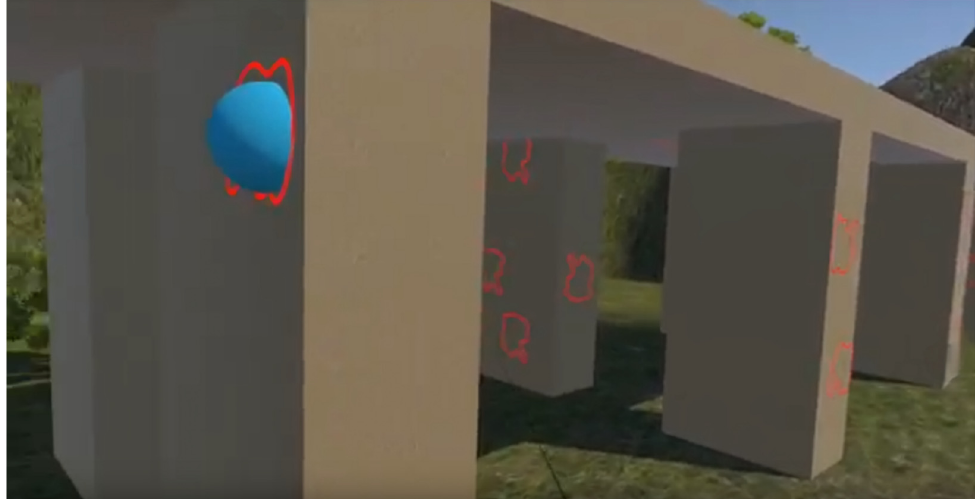
Figure 2. Simulated bridge environment as displayed to a participant during the experiment. The blue hemisphere in the upper left of the figure denotes an area where the participant selected and the black line in the bottom center of the shows the ray-casting marker, used to display where the user is pointing.